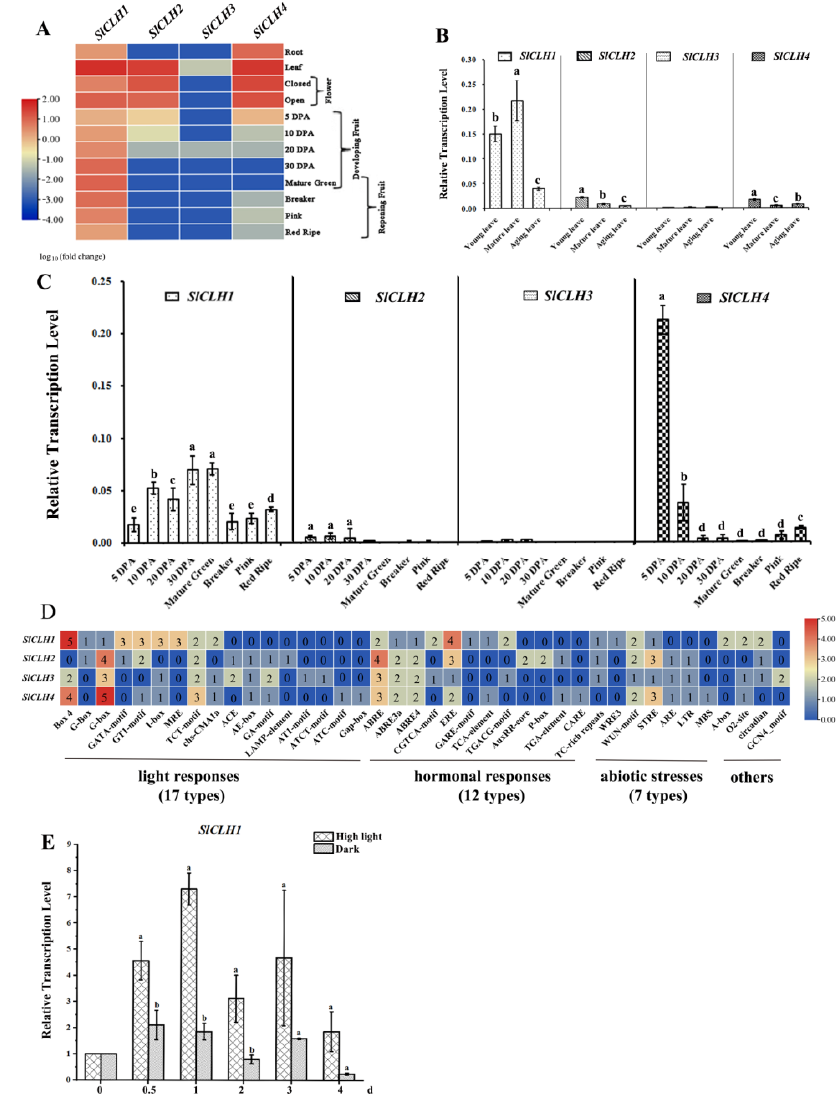
Figure 1. Expression profiles of four SlCLHs . ( A ) Relative expression values for SlCLHs in plant development and fruit ripening (root, leaf, bud, flower, 4 fruit developmental stages, mature green (MG), breaker (BR), pink and red ripe (BR + 10)) was calculated Log 10 RPKM values derived from RNA-seq data from the SGN database (http://ted.bti.cornell.edu/cgi-bin/TFGD/digital/search.cgi?ID=D004, S. lycopersicum cv. Heinz; https://tea.solgenomics.net/expression_viewer/input, S. lycopersicum M82); The date accessed on 26 May 2022. ( B , C ) Quantitative real-time PCR of SlCLH genes in different leaf development ( B ) and fruit development/ripening stages ( C ). The relative transcript levels were displayed as expression ratio between SlCLH genes and the reference gene. ( D ) Cis -acting element analysis of the promoter region of SlCLHs . The cis -elements located in the 3000 bp promoter sequence (upstream of the start codon) of all SlCLHs were analyzed via the PlantCARE website. The number of corresponding cis -acting elements was used for the heatmap construction. ( E ) Changes in SlCLH1 transcript levels in mature green tomato, which responded to continuous high light and dark treatment, respectively. The samples were collected at 0.5, 1, 2, 3, and 4 days after high light treatment. Data represent means ± the standard deviation of three biological repeats. One-way analysis of variance (ANOVA) with Tukey’s method was applied to show the significant differences in ( B , C , E ) at p < 0.01 in pair-wise comparison and classified with the letter